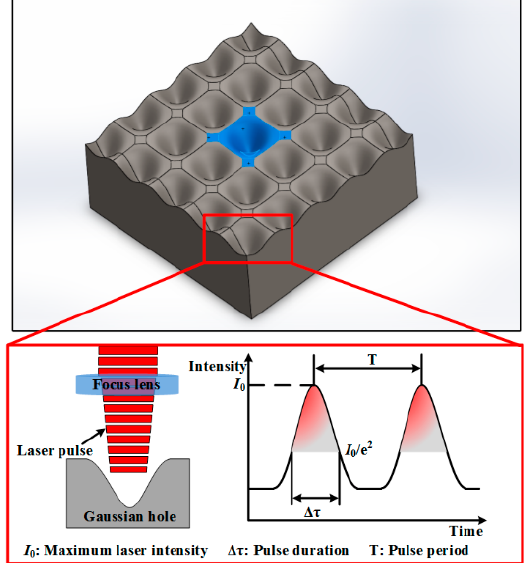
Figure 2. Schematic of periodic Gaussian holes machined by the laser ablation process.